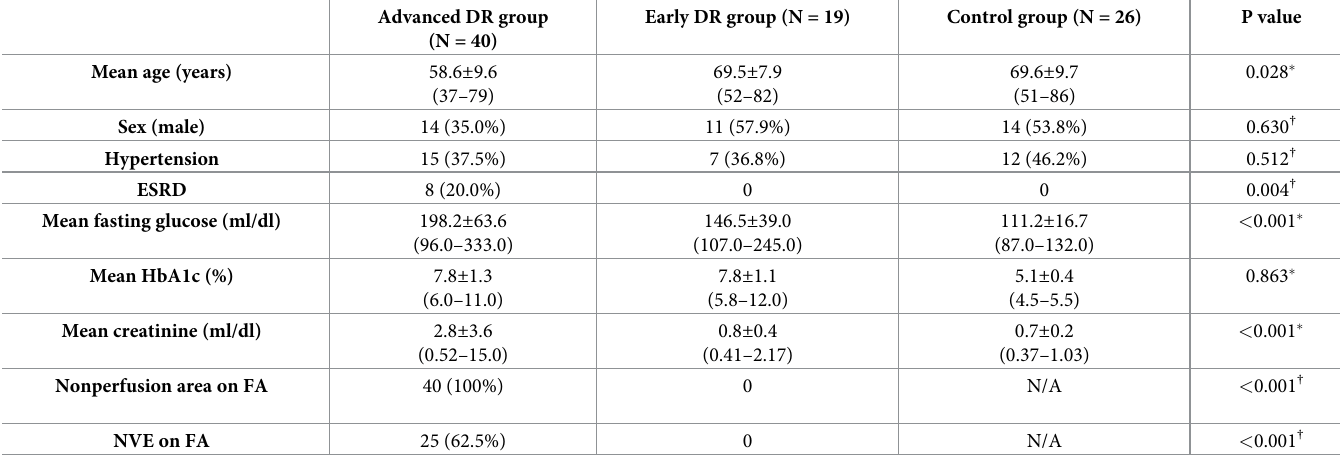
Table 1. Baseline characteristics of the study